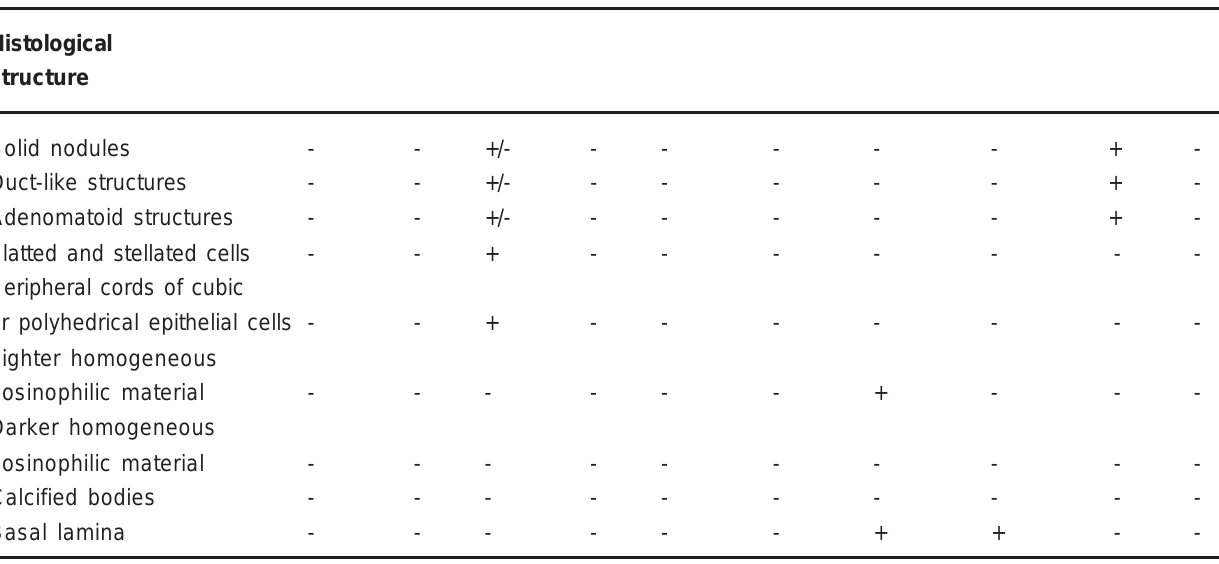
TABLE 2- Immunohistochemical staining of epithelial components of adenomatoid odontogenic tumor by monoclonal antibodies directed against different